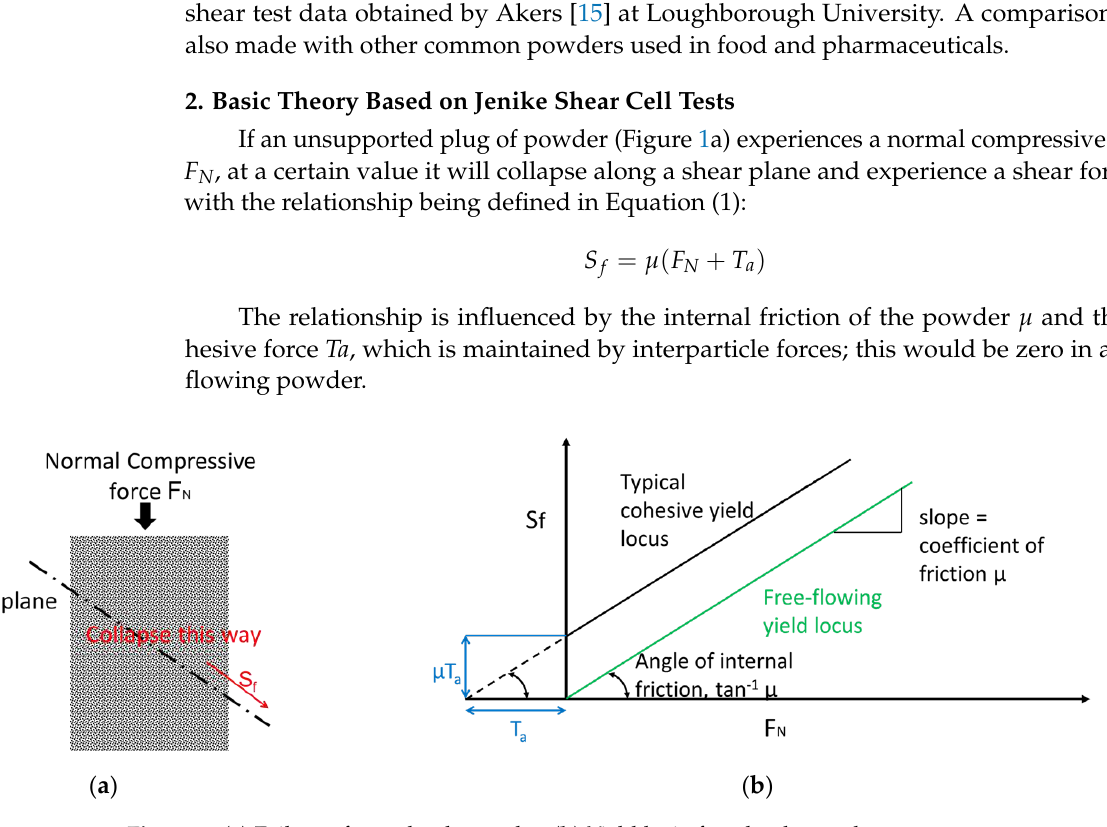
Figure 1. ( a ) Failure of a coulomb powder. ( b ) Yield loci of coulomb powders.